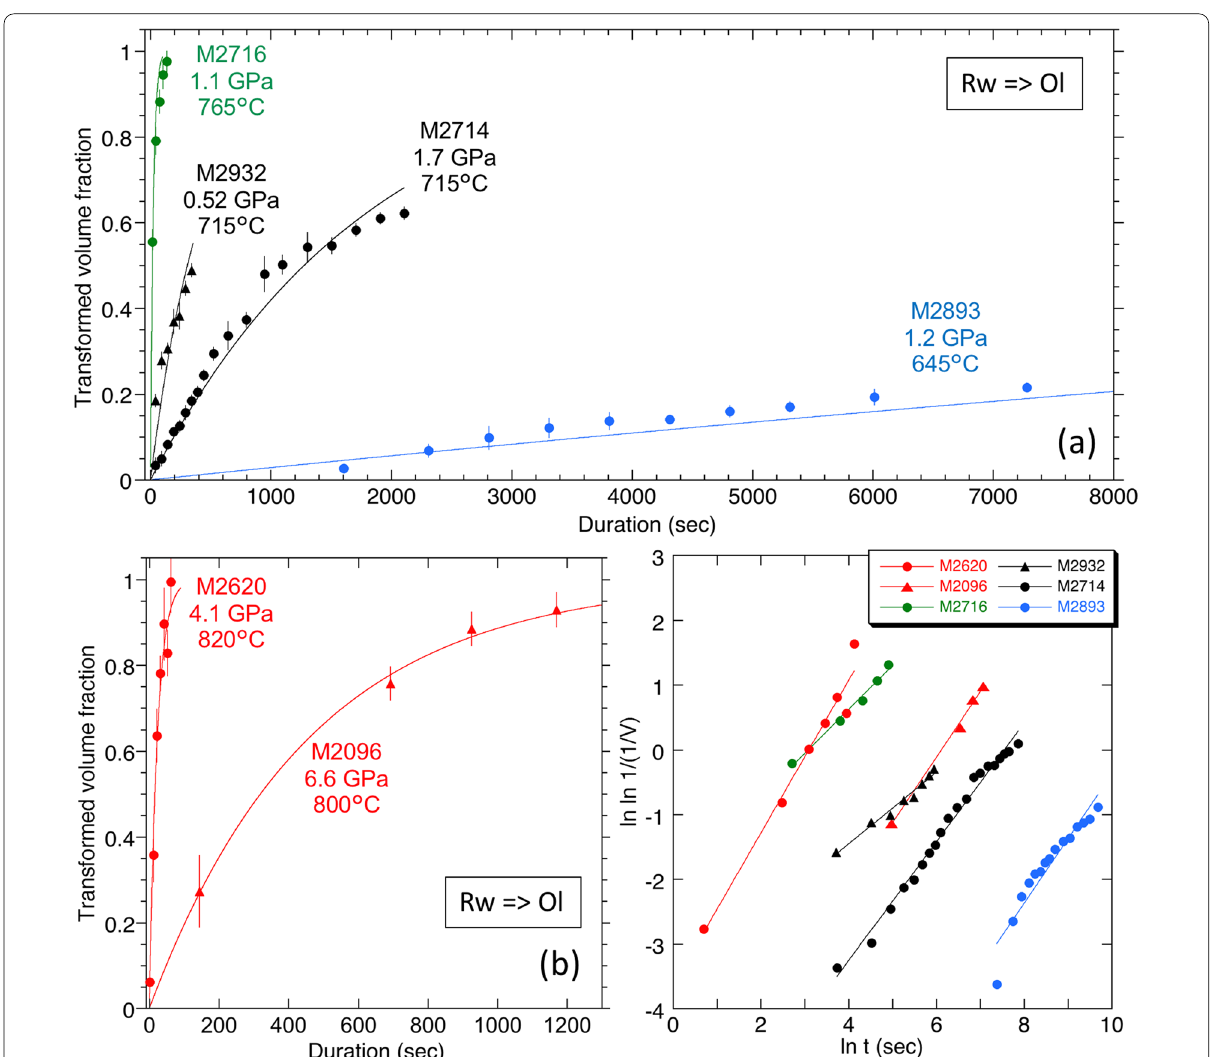
Fig. 10 Back-transformation kinetics from ringwoodite to olivine. a , b Transformation-time data at six different P–T conditions. Curves obtained by least-squares fits of the kinetic data to Eq. (1) are also shown. Note that Run M2893 lasted 18,340 s until the transformed fraction reached ~ 34 vol% although kinetic data with t > 8000 s is not shown. c Plots of ln ln {1/(1 V )} against ln ( t ). The intercept and the slope are corresponding to the − values of ln k and n ,